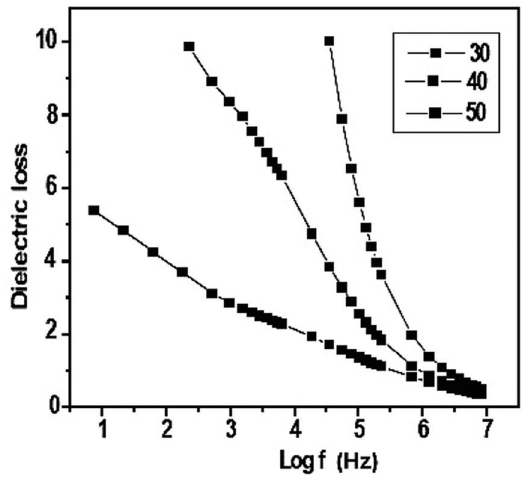
Figure 6: Dielectric loss of CoS thin